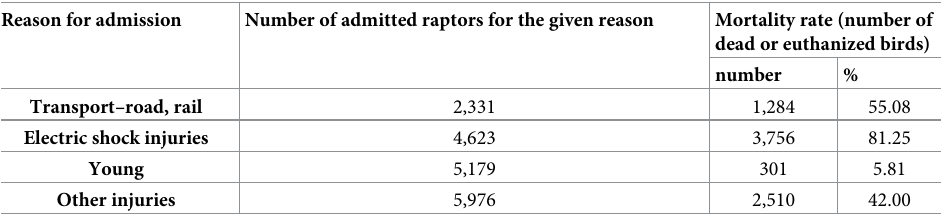
dead or euthanized birds) number %